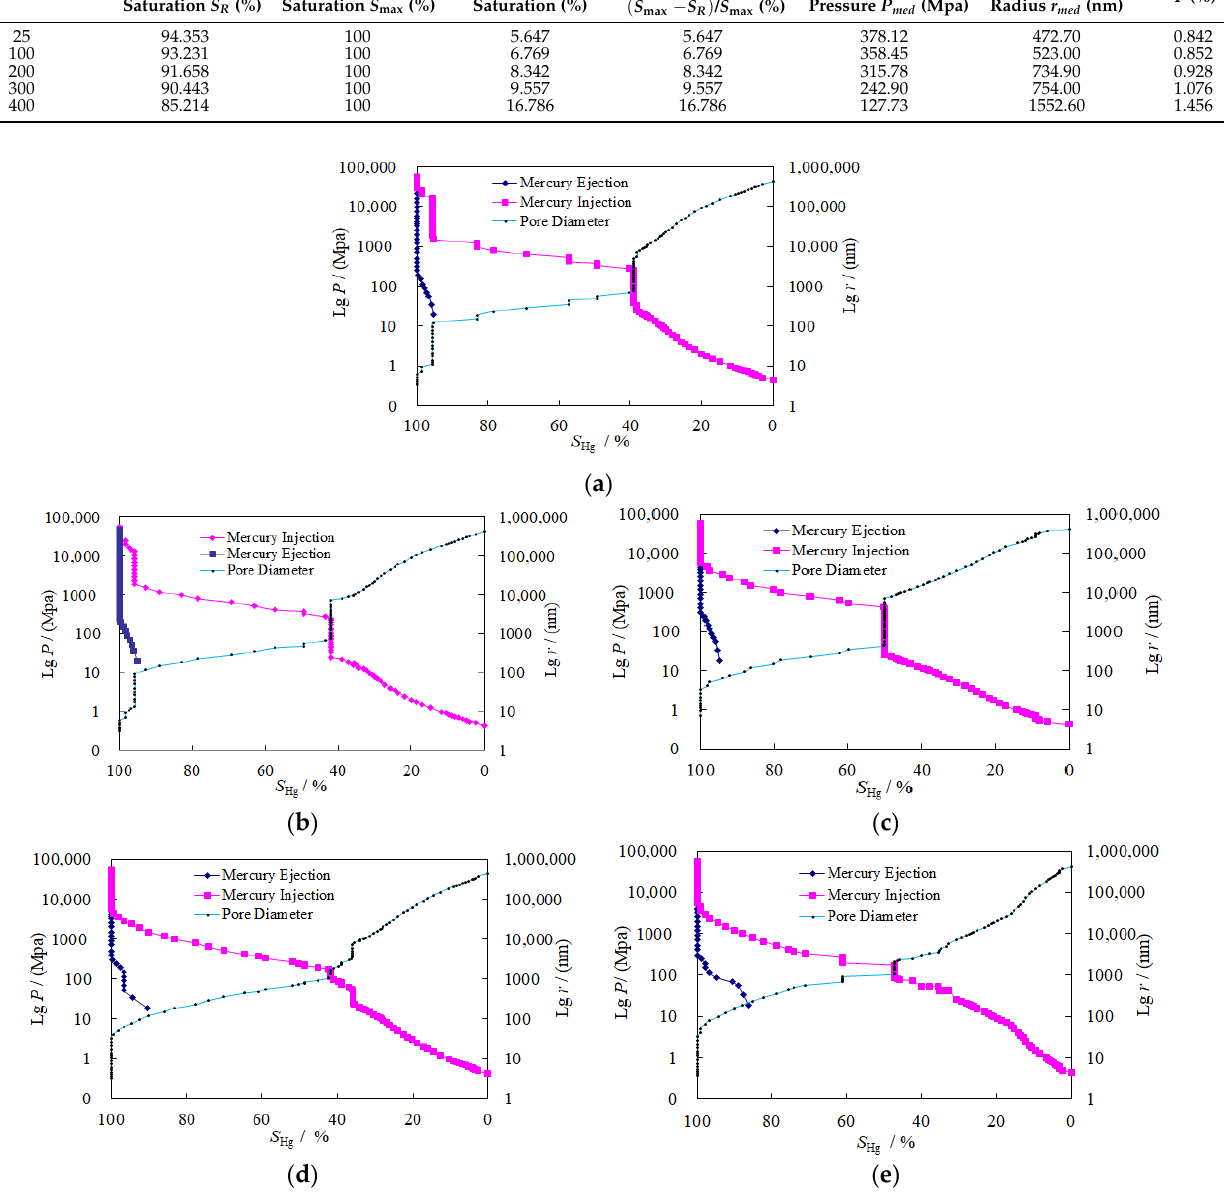
Figure 5. Capillary pressure curves and pore diameters of granite at different temperatures: ( a ) 25 °C, ( b ) 100 °C, ( c ) 200 °C, ( d ) 300 °C, ( e ) 400 °C.